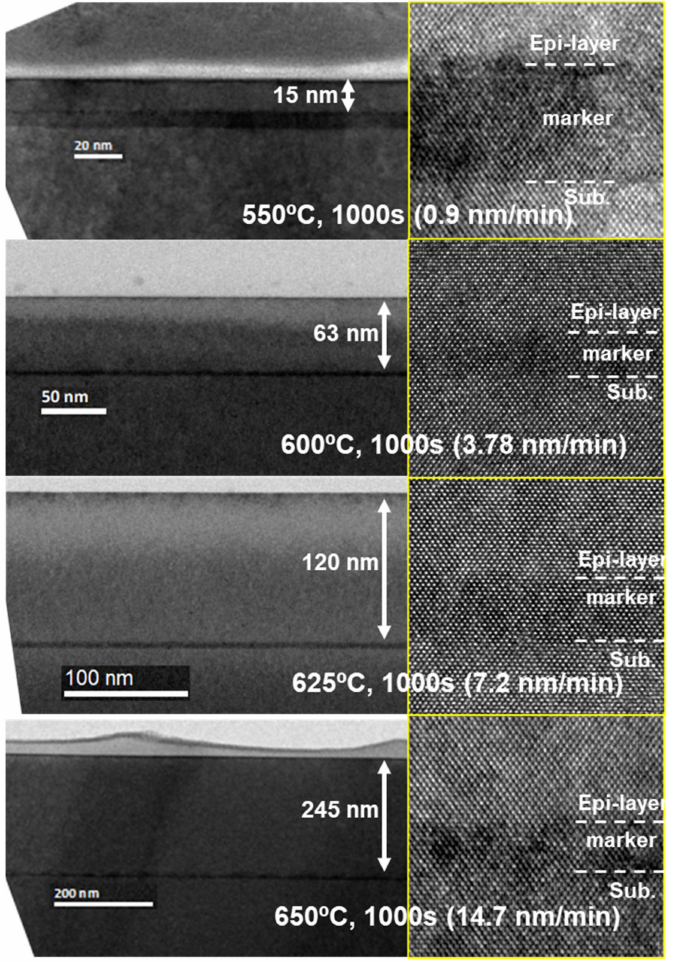
Figure 1. Cross-sectional TEM images of the Si layers grown using disilane at 550–650 ◦ C with a SiGe marker layer. High-resolution TEM images of the interface are also